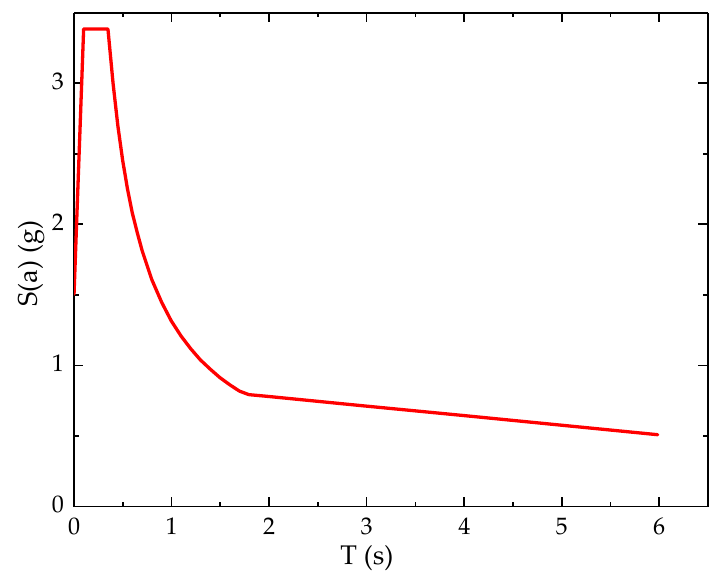
Figure 11. Acceleration response spectrum curve.